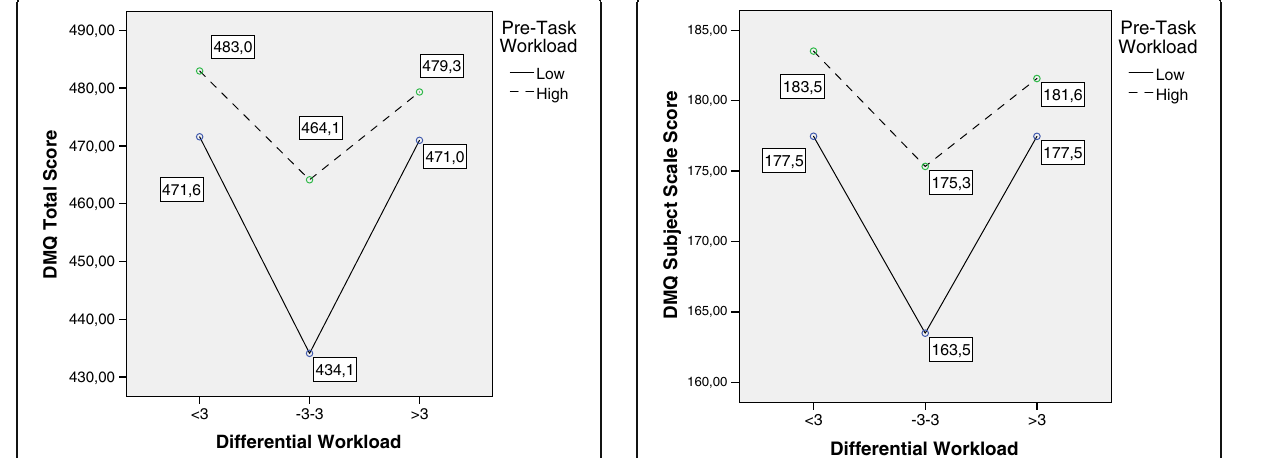
Fig. 6 MANOVA. Estimated marginal means. Differential Workload vs. Decision-Making Questionnaire Subjects scale. DMQ Decision-Making